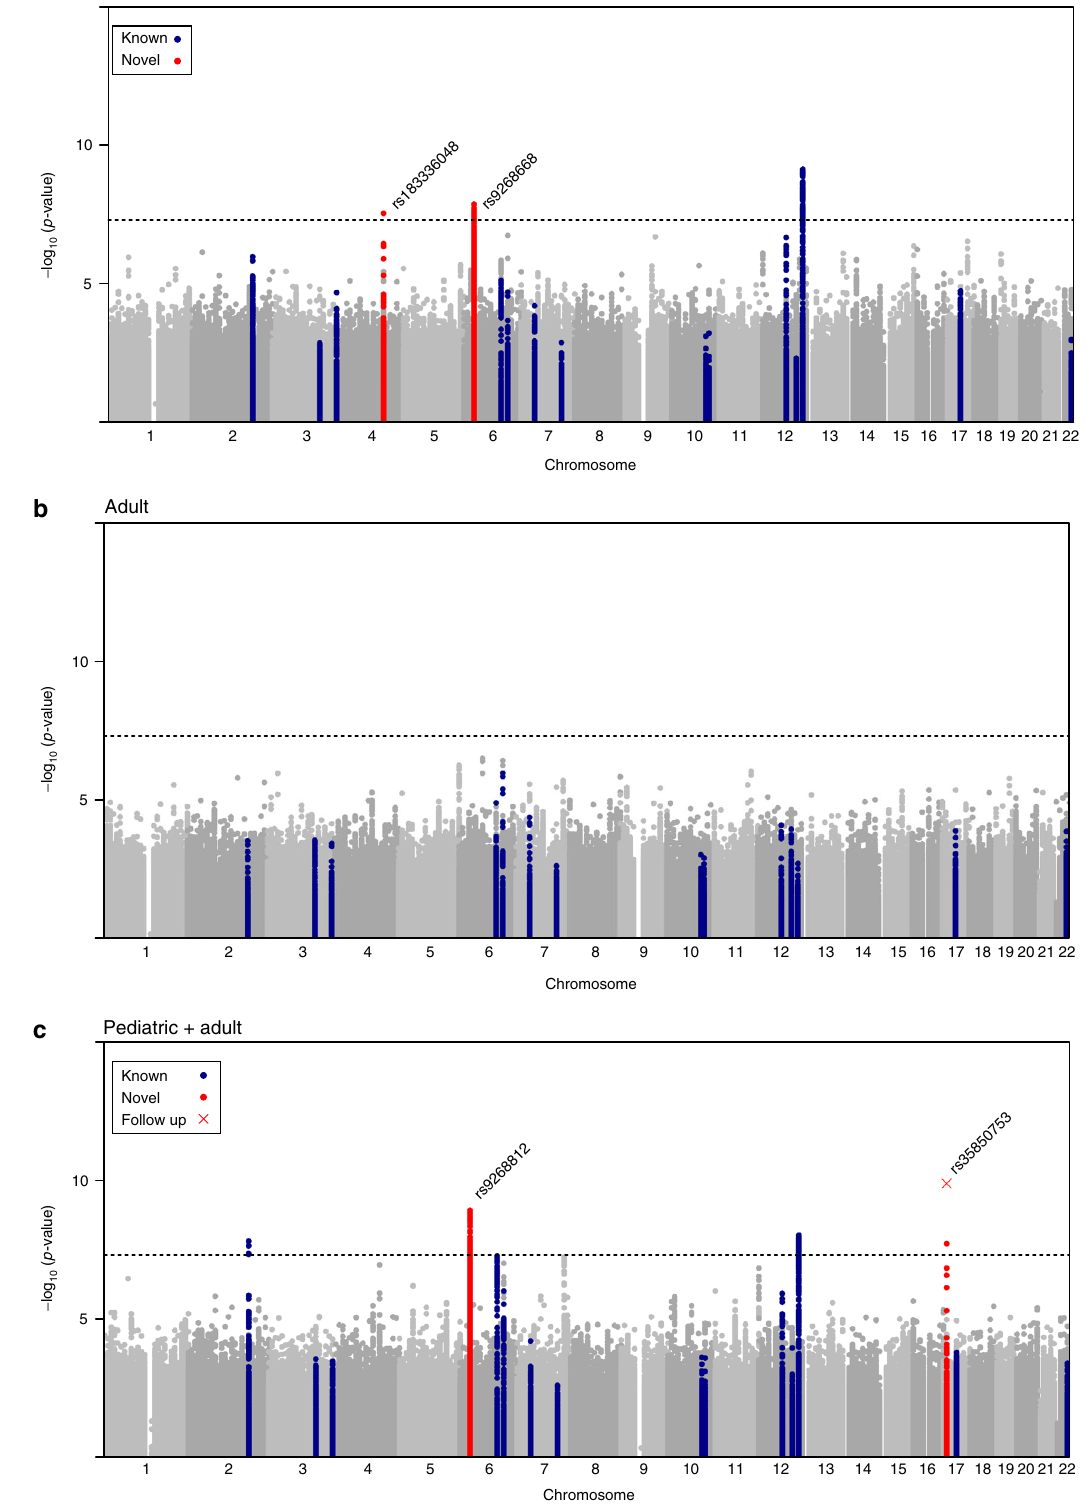
Fig. 2 Genome-wide association with fi nal head circumference (HC). a HC(Pediatric): N = 8281, b HC(Adult): N = 10,600 and c HC(Pediatric + adult): N = 18,881 inverse-variance weighted meta-analyses. The dashed line represents the threshold for nominal genome-wide ( p < 5.0 × 10 − 8 ) signi fi cance. Accounting for multiple testing, the adjusted level of genome-wide signi fi cance is p < 3.3 × 10 − 8 . Known variants for intracranial volume, brain volume, and head circumference are shown in blue. Novel signals passing a nominal genome-wide association threshold ( p < 5.0 × 10 − 8 ) are shown with their lead SNP in red. Replicated signals are labeled with a red cross. The genomic position is shown according to NCBI Build